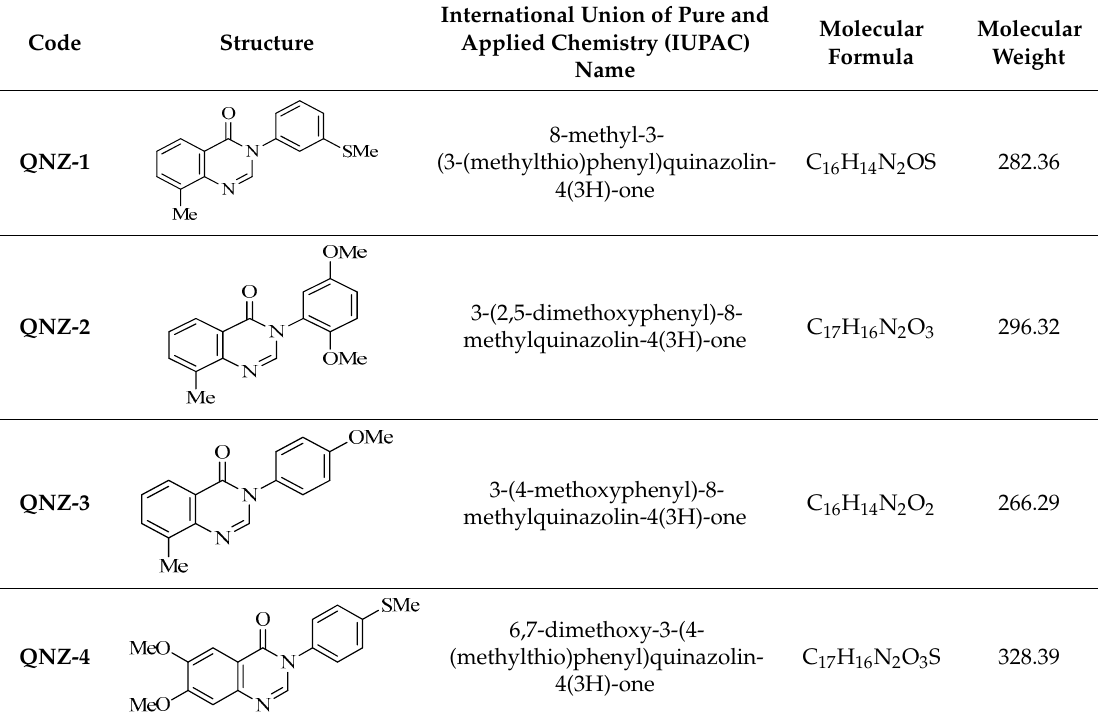
Table 2. The chemical definitions of six quinazolinone derivatives.